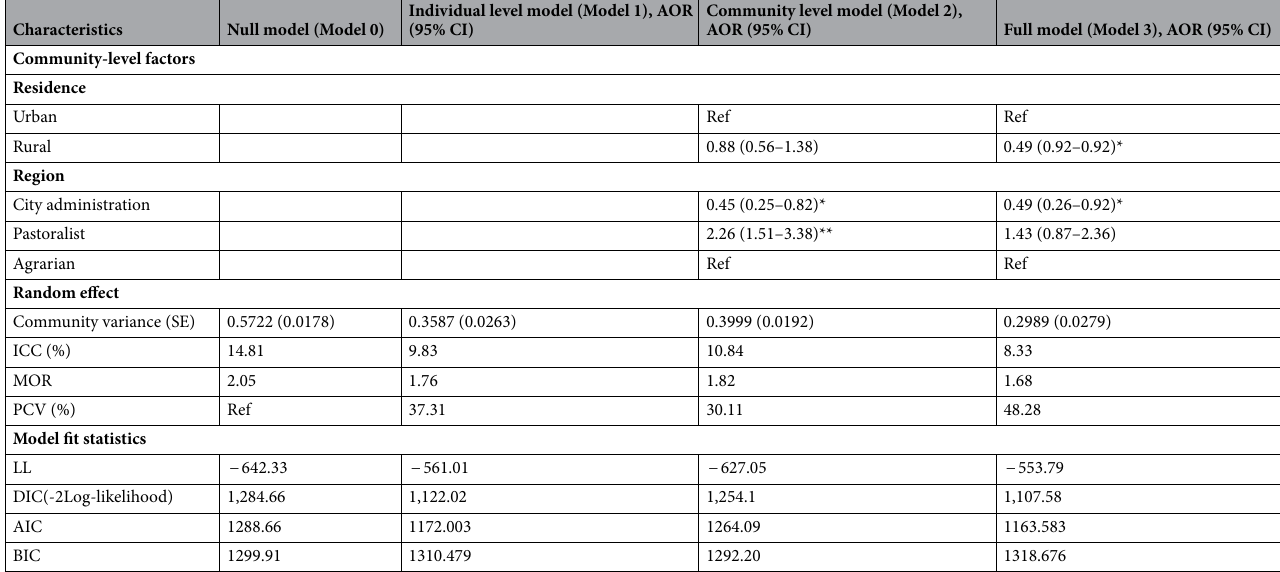
Table 4. Multivariable multilevel logistic regression analysis of factors associated with childhood wasting among children aged 0 – 23 months in Ethiopia, EMDHS 2019. ** p -value < 0.001; * p -value < 0.05; SE Standard Error; ICC Intra-class Correlation Coefficient; MOR Median Odds Ratio; PCV Proportional Change in Variance; AIC Akaike’s Information Criterion; BIC Bayesian information Criteria; DIC Deviance Information Criterion; LL